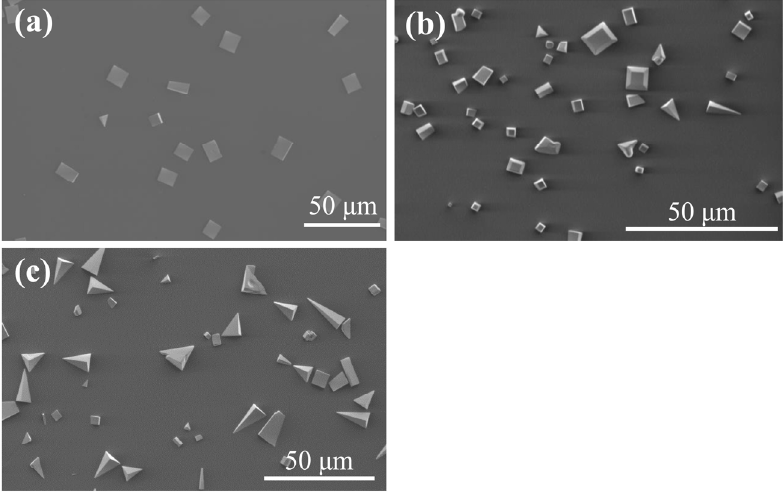
Figure 2. The SEM images of the microcrystals synthesized at the carrier gas flow rate of ( a ) 40, ( b ) 80, and ( c ) 120 sccm, respectively. Heating temperature of the source: 600 °C. Substrate temperature: 340 °C. Inner pressure: 380 Torr. Molar ratio of PbBr 2 and CsBr: 1:2.